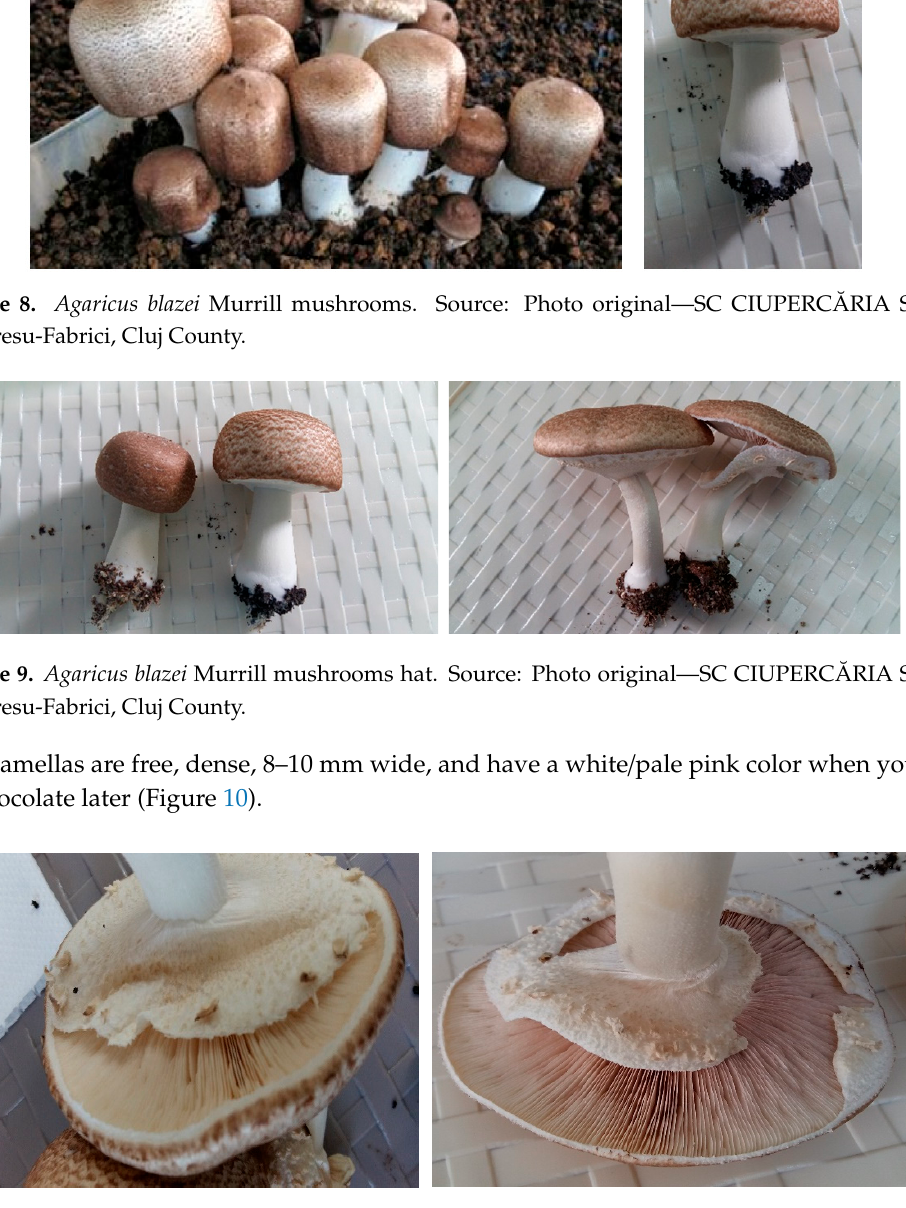
Figure 10. Agaricus blazei Murrill mushrooms blades. Source: Photo original—SC CIUPERC Ă RIA SRL, Aghiresu-Fabrici, Cluj